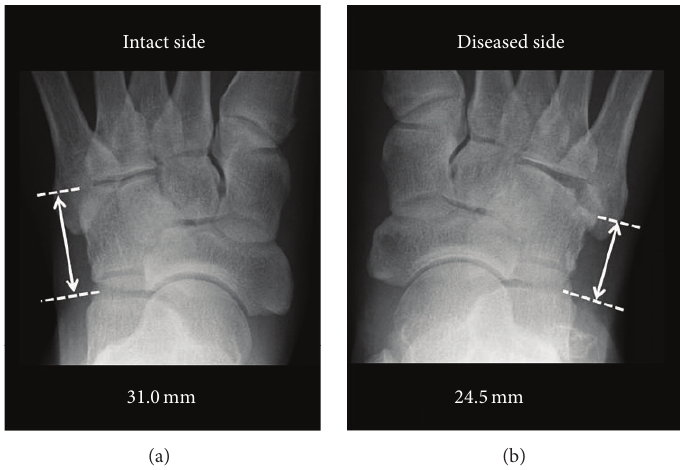
Figure 1: (a) Normal side with a lateral column of 31.0mm. (b) Affected side with a lateral column of 24.5 mm.